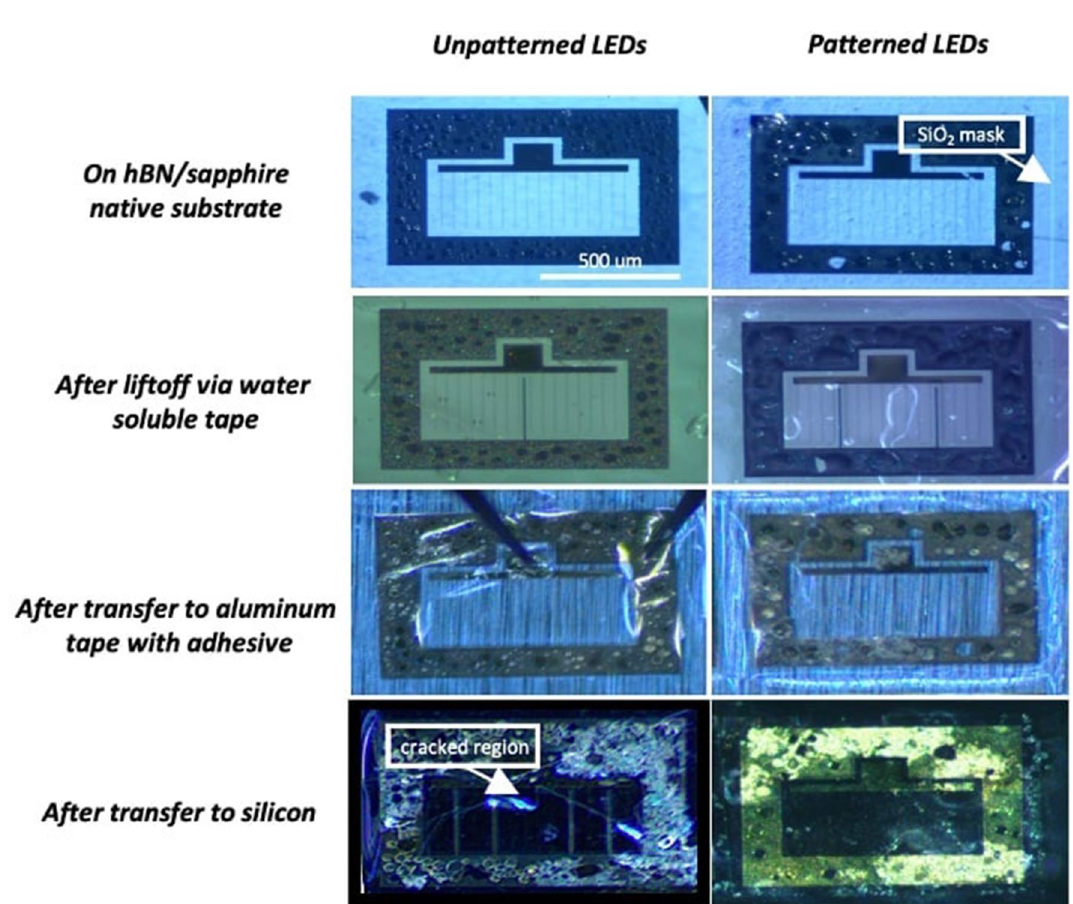
Figure 6. Microscope images of the devices taken at the different steps of the transfer process for both unpatterned and patterned structures: after the fabrication process, lift-off, and transfer on aluminum tape and silicon